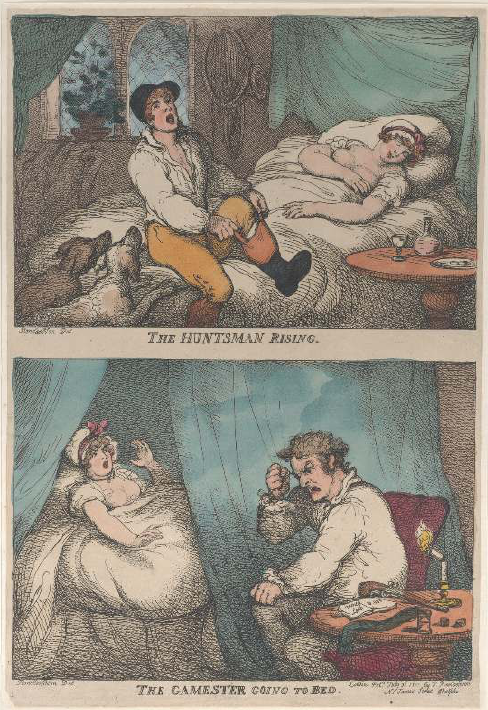
In an interesting juxtaposition, this etching by Rowlandson (see above one of his other engravings) enables us to slip from meaning II (“An activity played for entertainment, according to rules, and related uses”) of the word “game” in English ( OED ) to meaning III: “Senses relating to hunting and the chase” ( OED ). The moralistic tone of the image is unmistakable: while the early-rising hunter contributes to the happiness of his wife and home, the gamester, coming back late from an unsuccessful game of dice, brings enormous debts (£ 10,000) as well as disarray at home, to the great indignation of his wife.